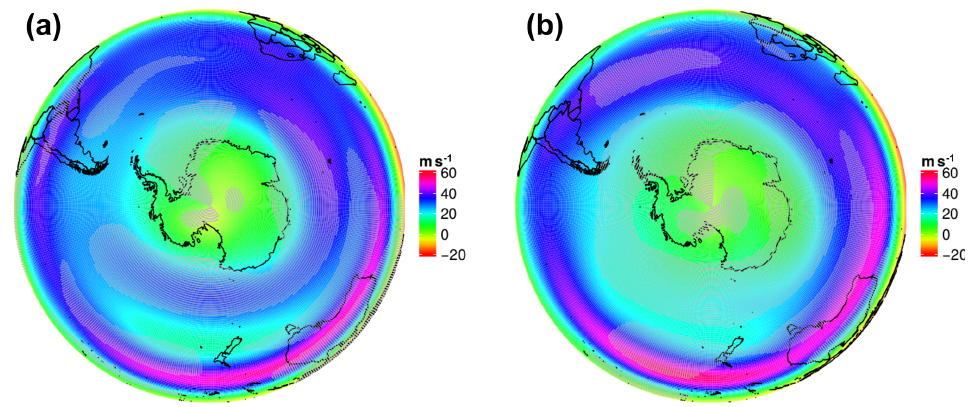
Figure 5. Positive (a) and negative (b) composites of the PSI (PC2–PC3) index in 200hPa zonal wind. Gray dotted areas are significant at the α = 1% level.